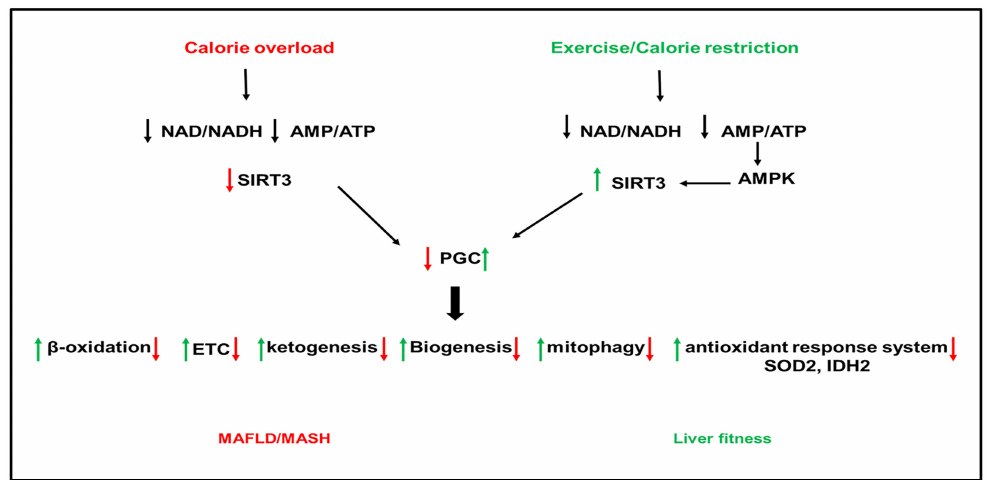
Figure 3. Role of sirtuins (SIRT) 3 in NAFLD. Calorie overload and liver lipotoxicity downregulate SIRT3 activity leading to the inactivation of PGC1 α . The inactivation of PGC1 α downregulates the downstream pathways, including β -oxidation, antioxidant enzymes (superoxide dismutase (SOD)2 and isocitrate dehydrogenase (IDAH)2, the ETC, ketogenesis, biogenesis, and mitophagy, leading to the development of hepatic steatosis, inflammation, and fibrogenesis. Activation of SIRT3 by exercise and calorie restriction activates PGC1 α with opposite effects on PGC1 downstream pathways than nutrient overload and lipotoxicity, leading to metabolic